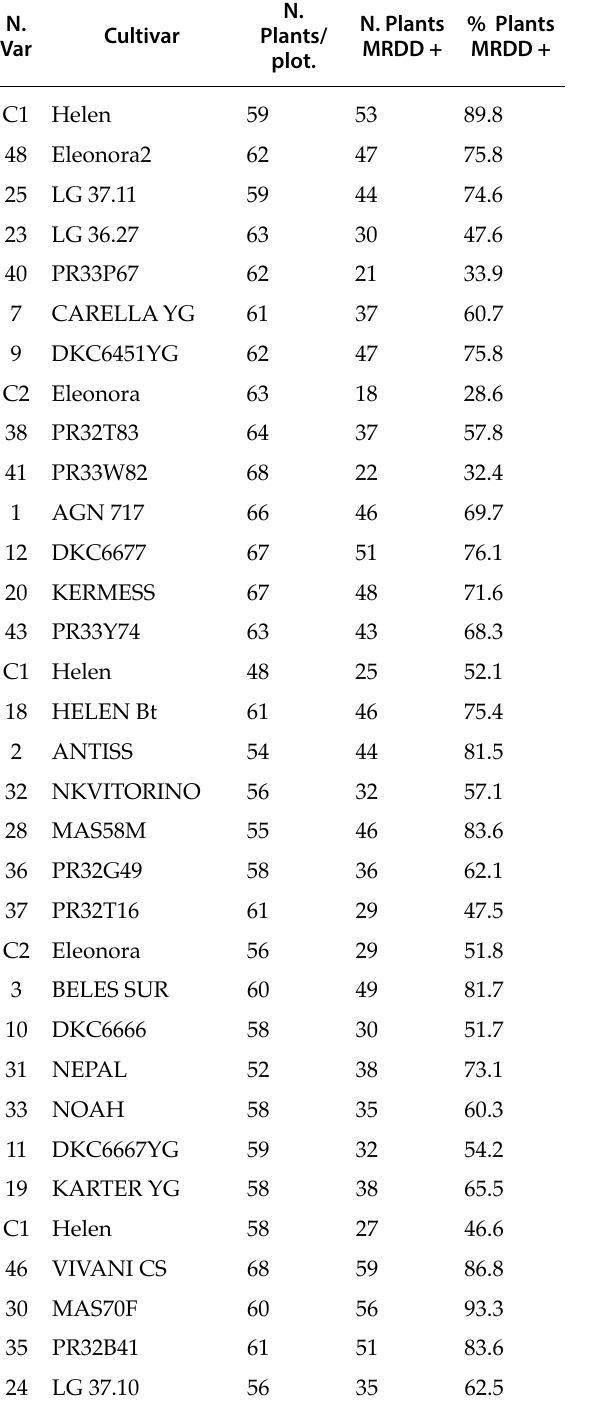
Table 1. Incidence of maize genotypes plants showing Maize rough dwarf disease (MRDD) in the locality of Gimenells, Spain. N. Cultivar Var